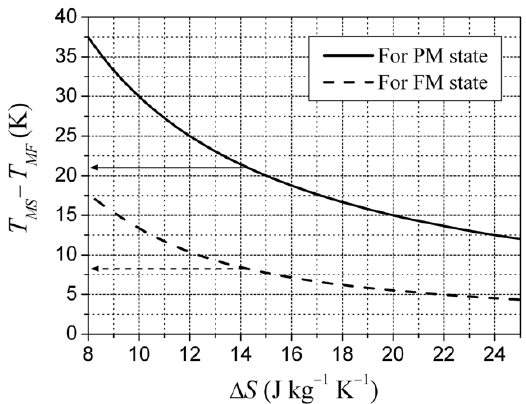
Figure 3. Temperature interval of MT as a function of the entropy change computed for the paramagnetic and ferromagnetic state of shape memory alloy (i.e., for zero and non‐zero values of magnetoelastic stress).